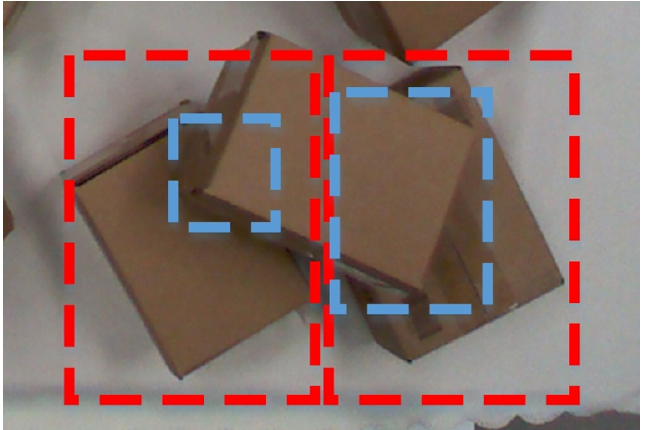
Figure 2. Stacked parcels occlude each other in complex